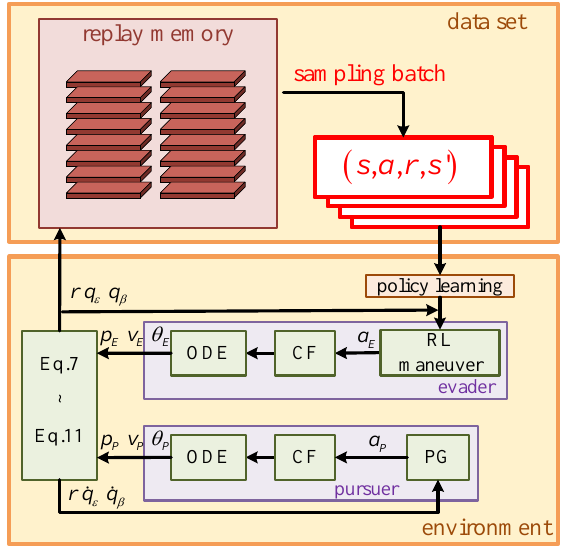
Figure 4. Complete learning